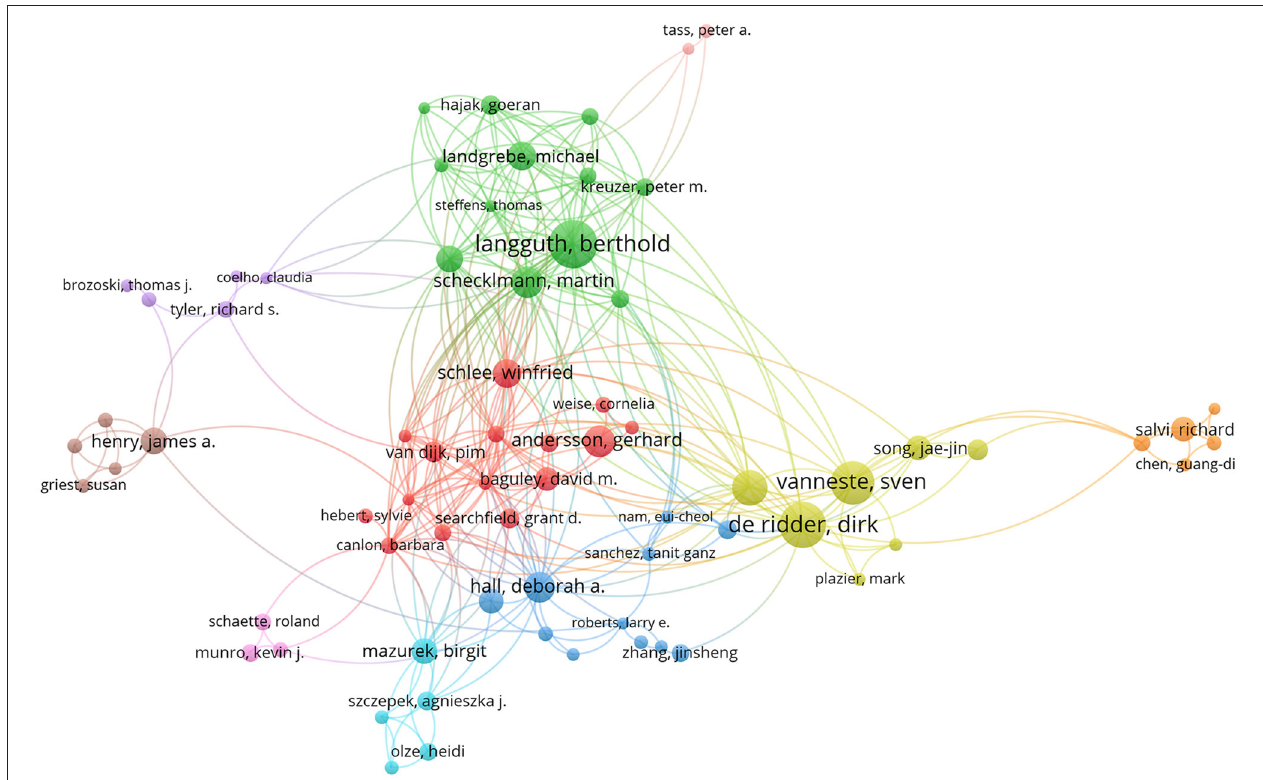
FIGURE 4 | Joint mapping of productive authors in tinnitus research from 2001 to 2020. The size of each colored circle is proportional to the total number of articles published by the author.